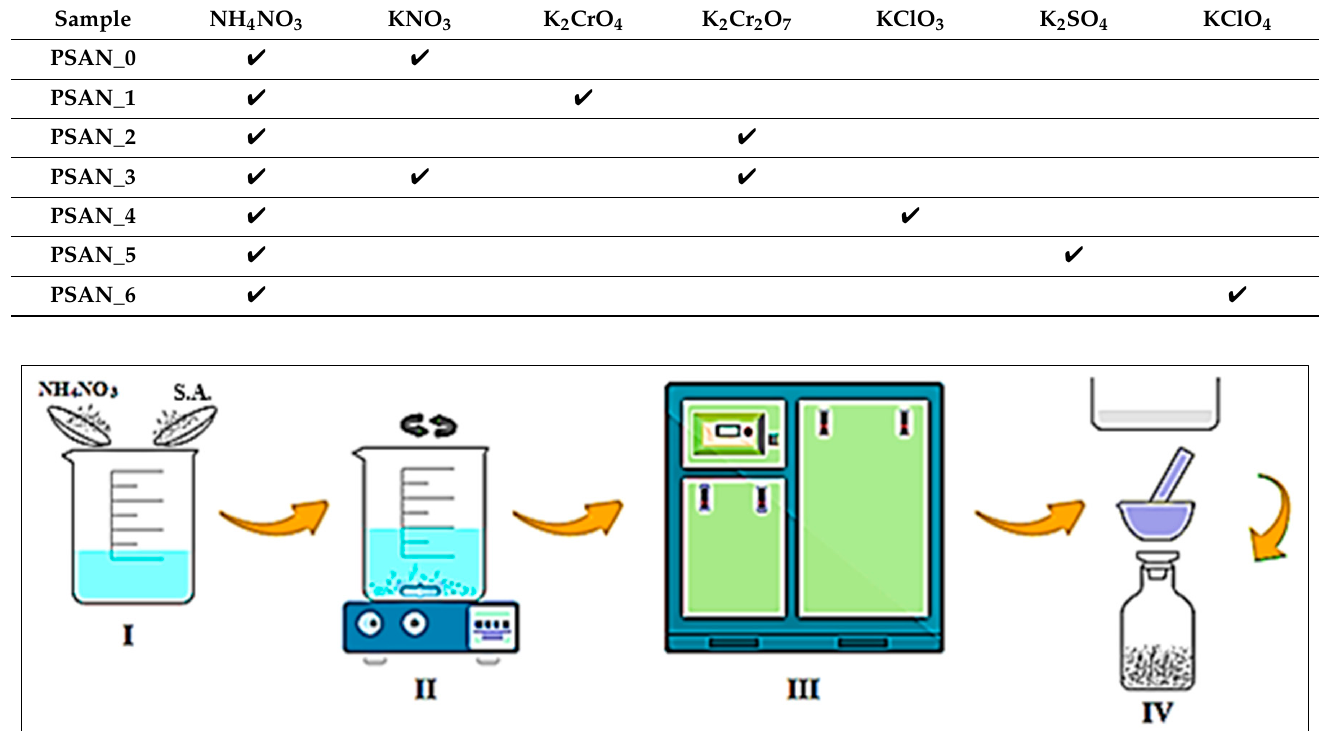
Table 1. The composition of phase-stabilized ammonium nitrate formulations.